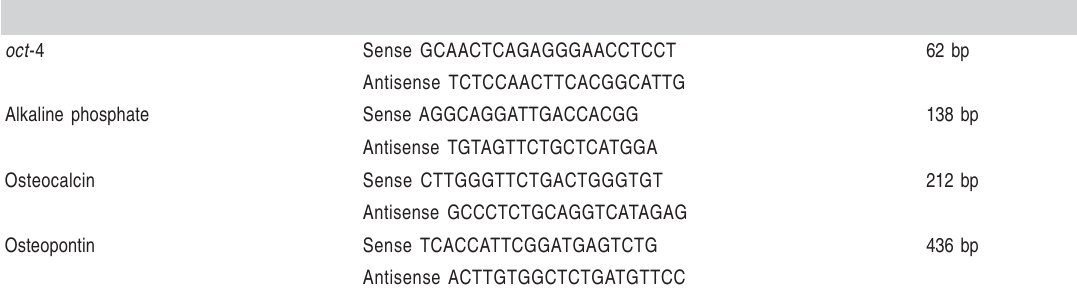
Table 1. RT-PCR primers